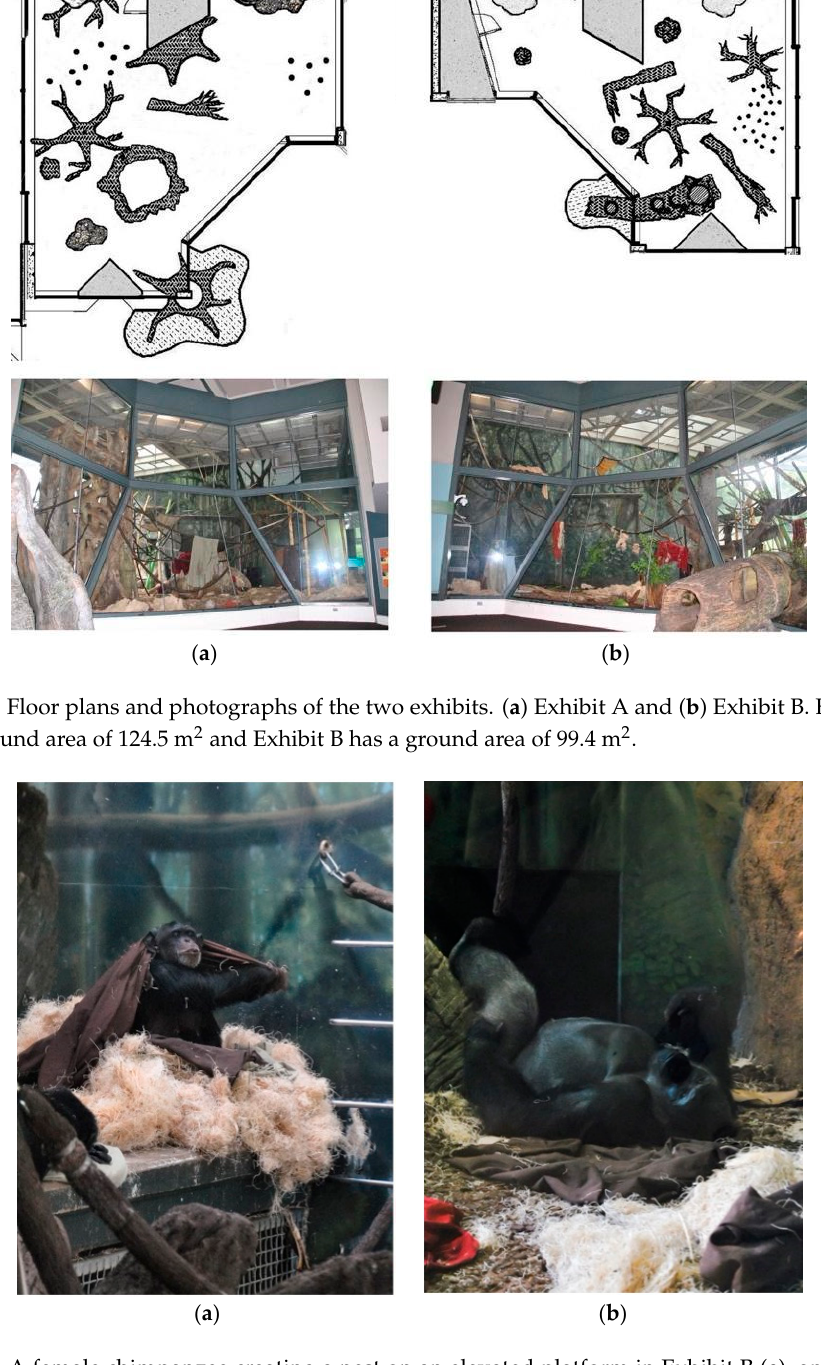
Figure 2. A female chimpanzee creating a nest on an elevated platform in Exhibit B ( a ), and a male gorilla resting terrestrially in Exhibit A ( b ).